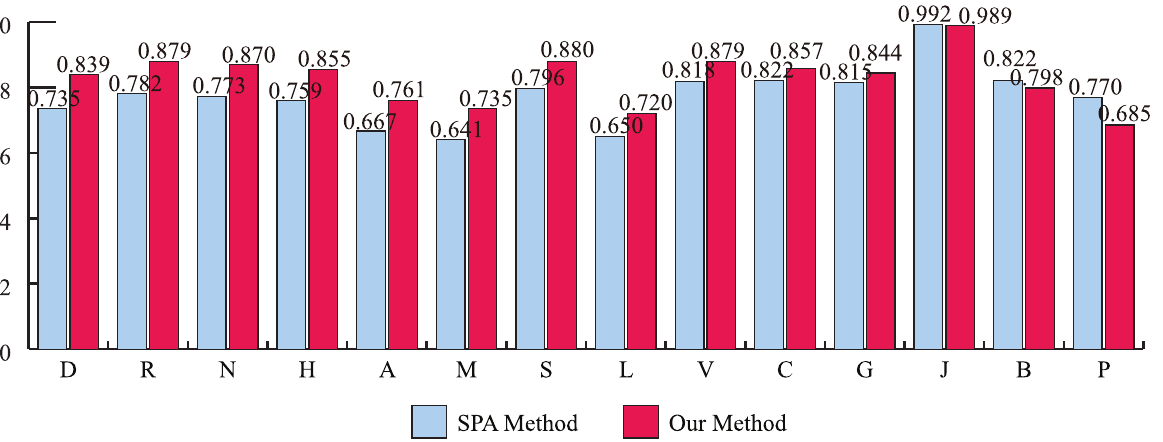
Fig 5. The AUC of our method and the SPA method for 14 ATC codes. For all of the ATC codes except J (antiinfectives for systemic use), B (blood and blood forming organs), and P (antiparasitic products, insecticides and repellents) codes, our method outperforms the SPA